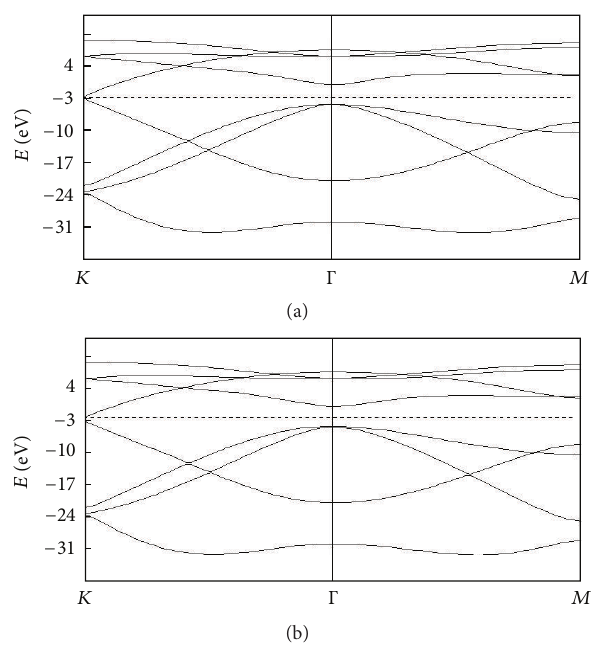
Figure 1: Band structure of “infinite” (𝑁 𝑎 = 𝑁 𝑏 = 91) silicone sheet (a) and band structure with a gap at 𝐾 -point of silicone nanoribbon “infinite” in a -direction (𝑁 𝑎 = 91) and finite (𝑁 𝑏 = 5) in b -direction (b). Doted line indicates Fermi level.